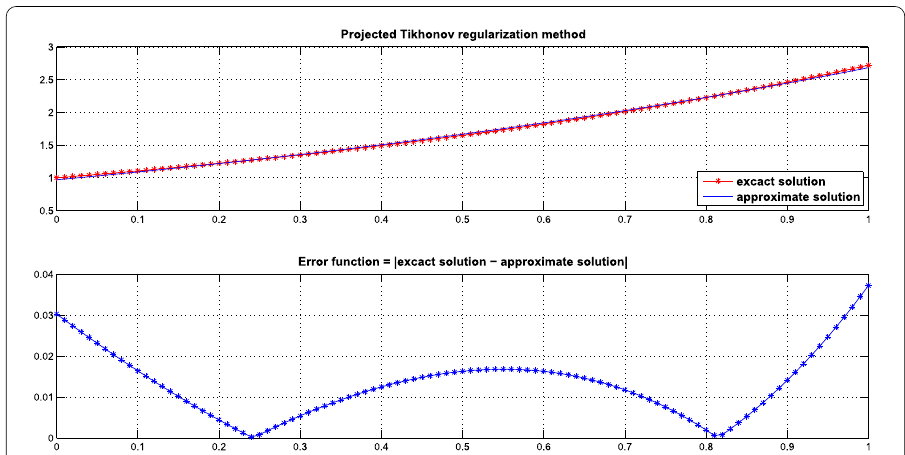
Figure 1 Example 1, noise level = 1/1,000, n =